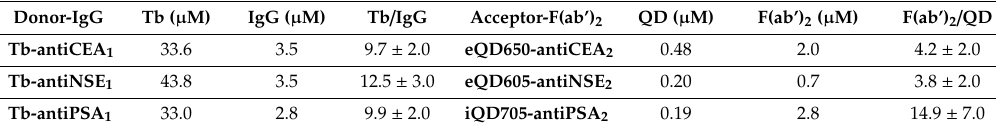
Table 1. Concentration of donor and acceptor AB conjugates and their respective conjugation ratios.